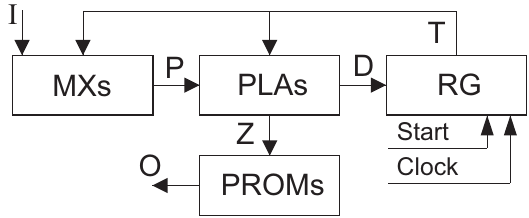
Figure 15. Heterogeneous circuit of MPY FSM.